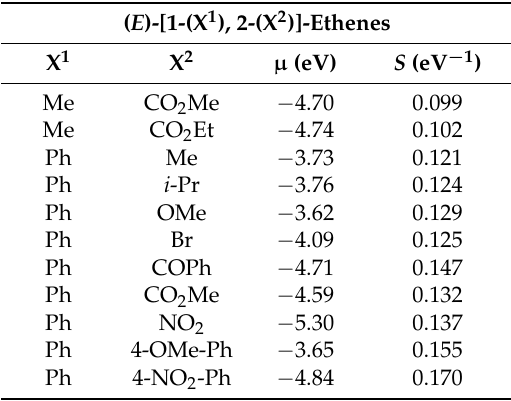
Table 5. Calculated chemical potential µ and global softness S of the investigated ( E )-[1-(X 1 ), 2-(X 2